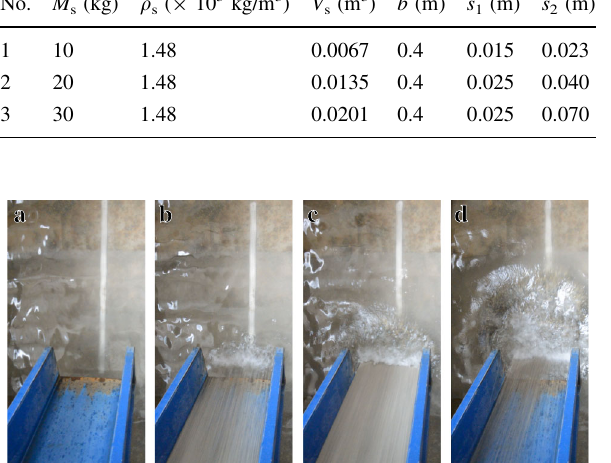
Table 2 Experimental conditions for granular material surge tests Tests tag no.